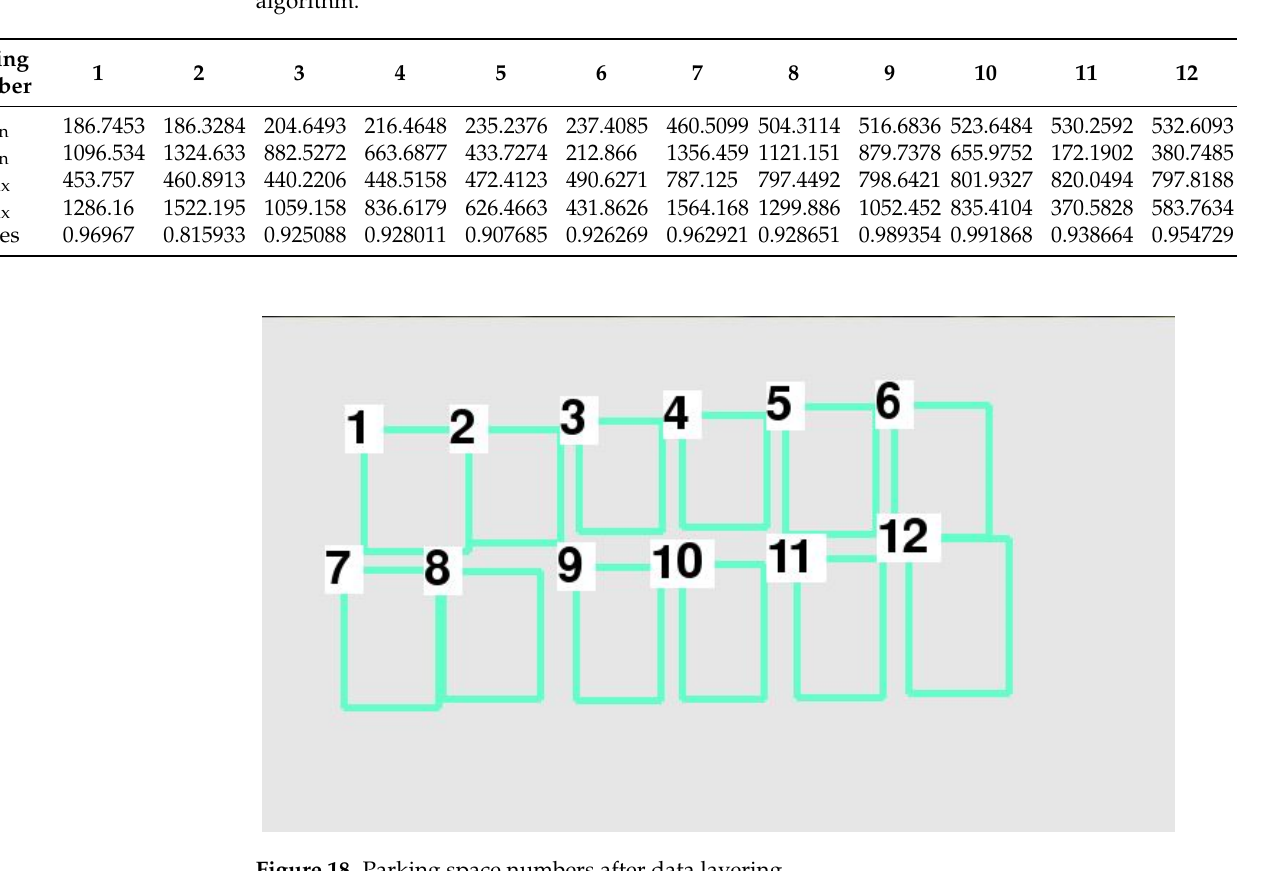
Figure 18. Parking space numbers after data layering. Table 6. Position of the vehicles after sorting and the numbering of the parking spaces by the data layering